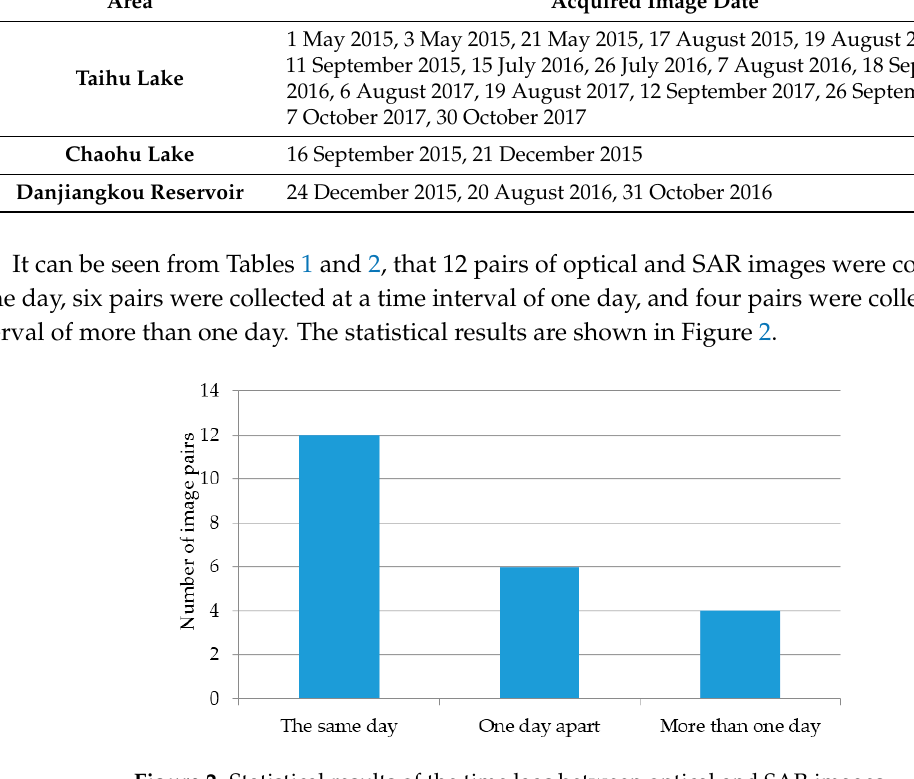
Table 2. Acquired optical images used in this study.